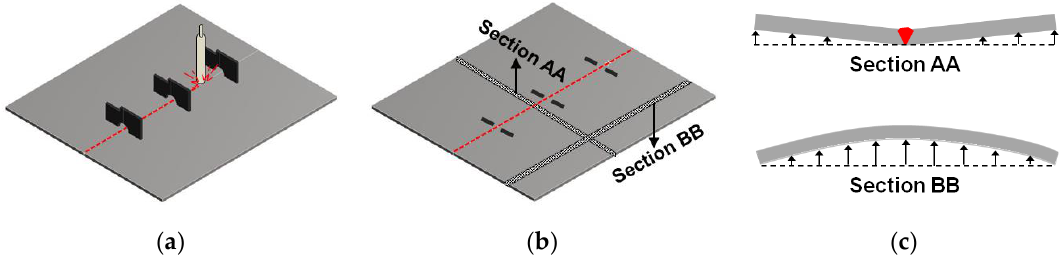
Figure 6. Sequence of procedures per experiments: ( a ) Flux cored arc welding; ( b ) piece removal; and ( c ) measurement.